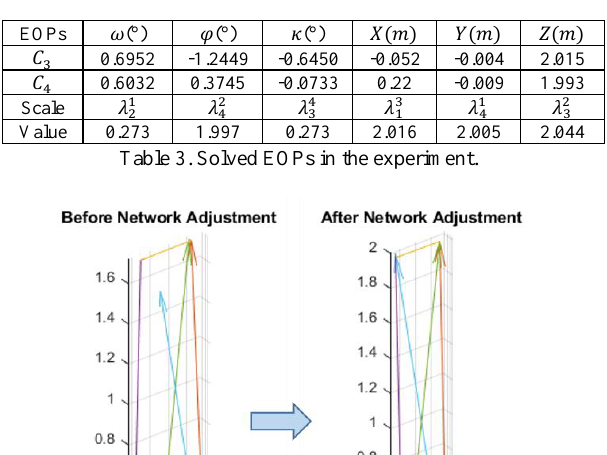
Figure 12. The experimental setting of the dual-camera system.